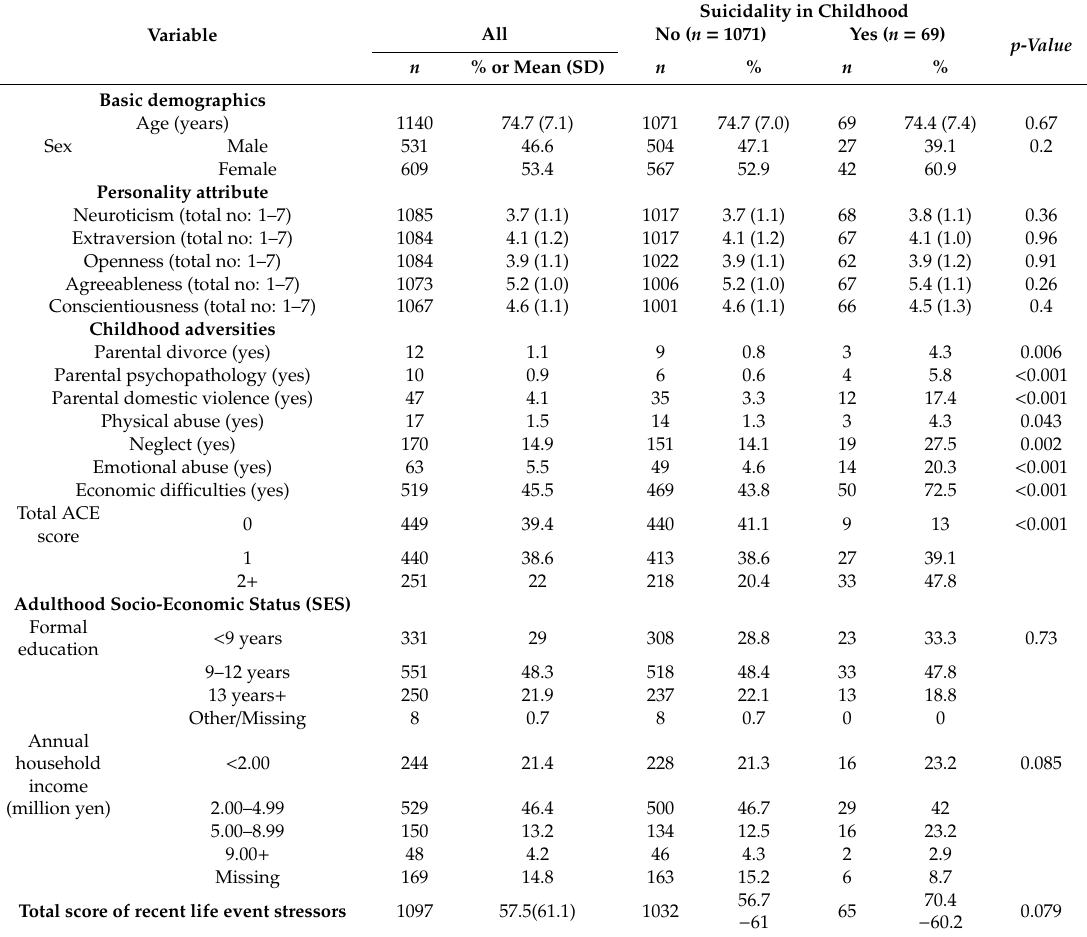
Table 1. Characteristics of the participants by childhood mental health ( n =